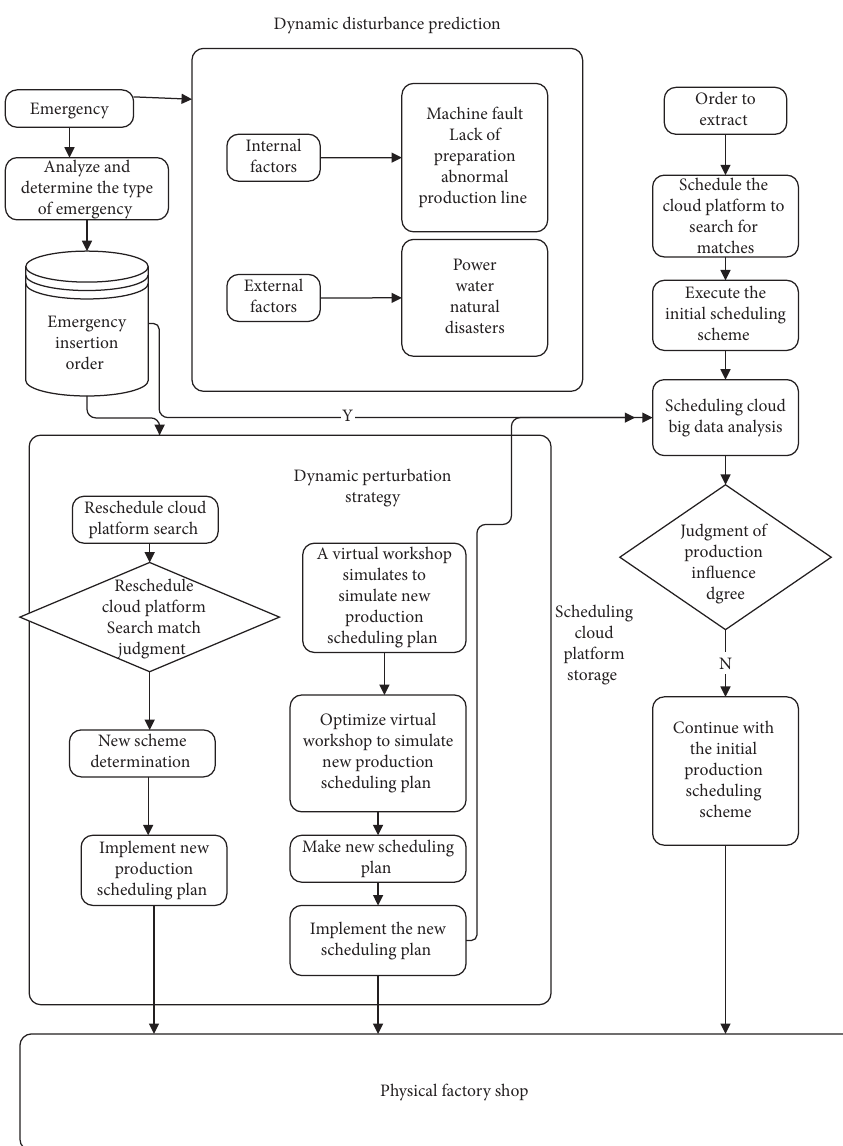
Figure 3: Intelligent manufacturing workshop scheduling cloud platform dynamic disturbance strategy